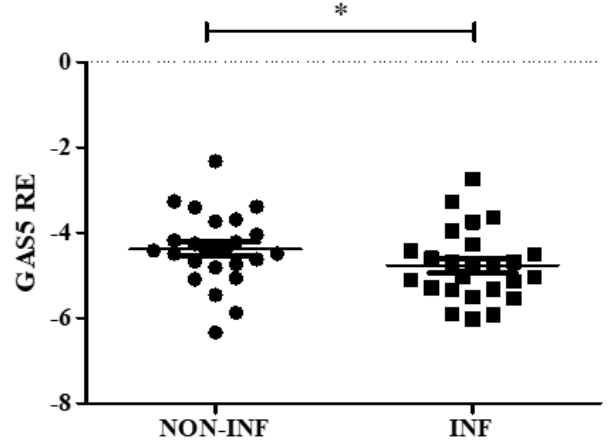
Figure 1. Growth arrest–specific transcript 5 ( GAS5 ) levels in colon biopsies of inflammatory bowel disease (IBD) pediatric patients. Expression was evaluated in inflamed (INF) and non-inflamed (NON-INF) tissues for each patient. GAS5 expression was normalized using RPLP0 gene. Relative expression (RE) values are expressed as Log 2 2 −Δ Ct . Paired t test * p < 0.05.